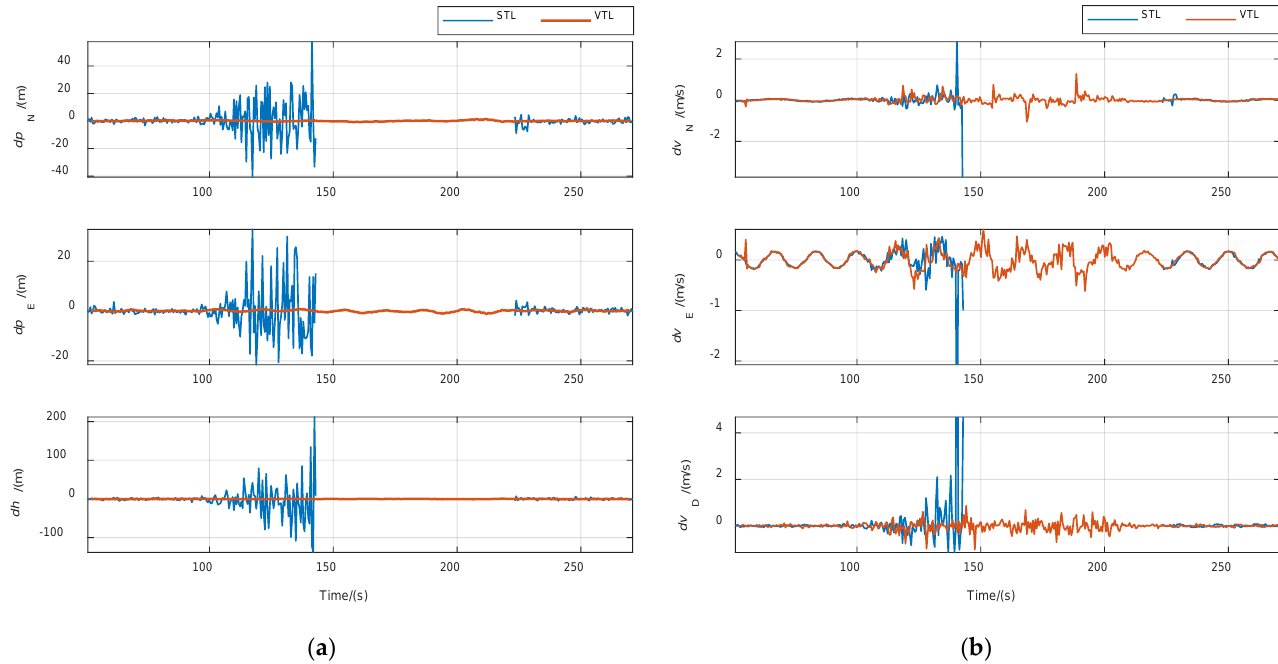
Figure 13. Comparison of navigation errors between STL and VTL in case of signal attenuation. ( a ) Position error; ( b ) velocity error.